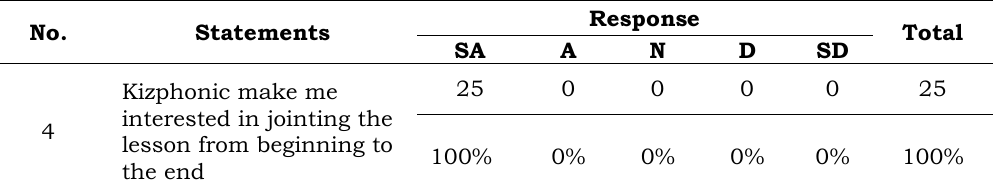
Table 6. Response to the questionnaire number 4